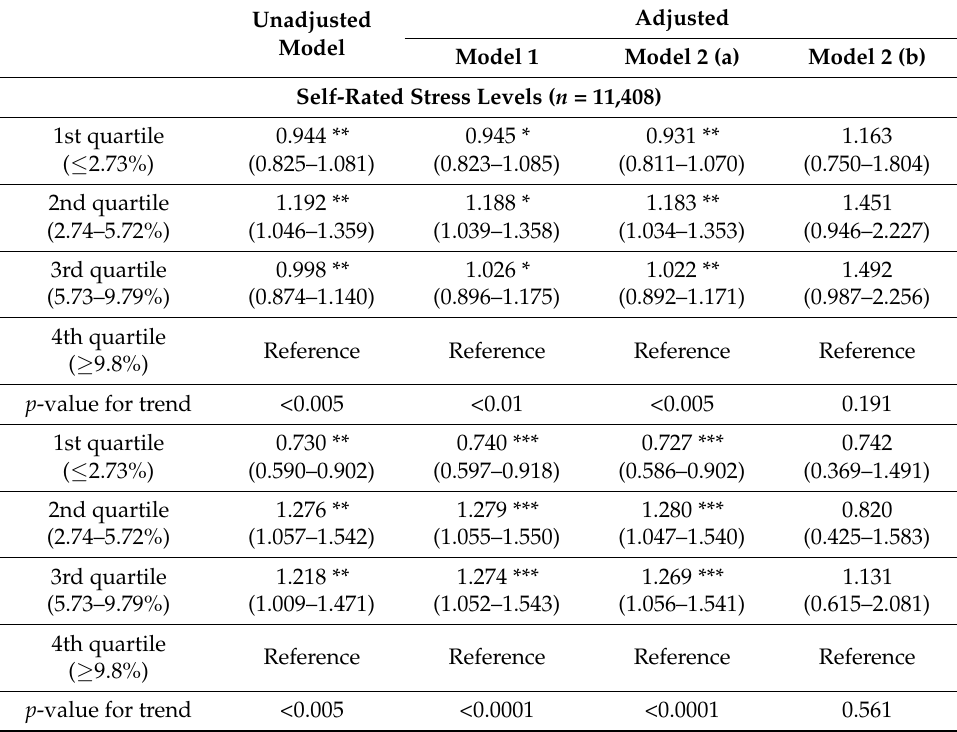
Table 3. Odds ratios (95% CI) of self-rated stress levels and symptoms of depression in quartiles of urban green area